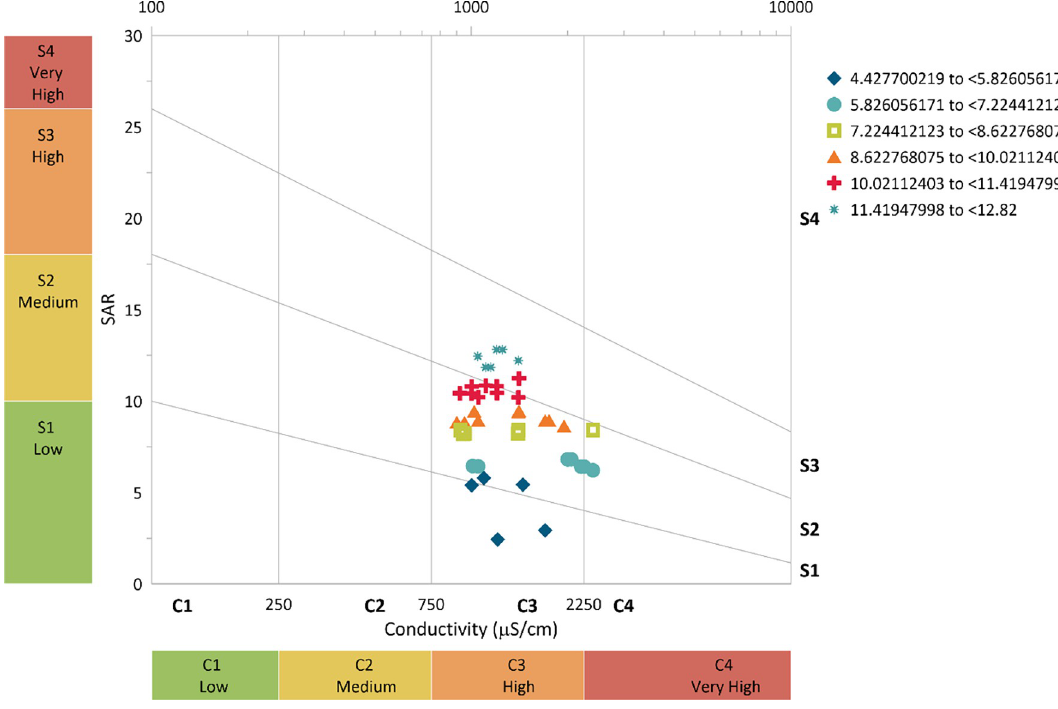
Fig 9. Salinity hazard from 0.5 m column effluent.